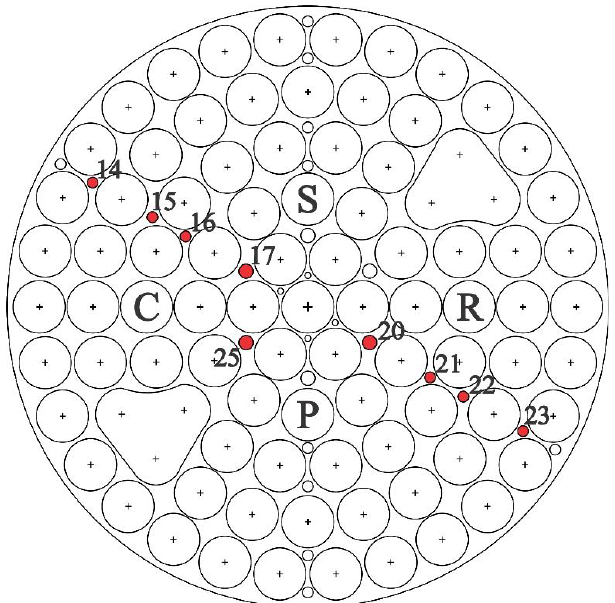
Fig. 2. Schematic of the JSI TRIGA core upper grid with denoted measuring